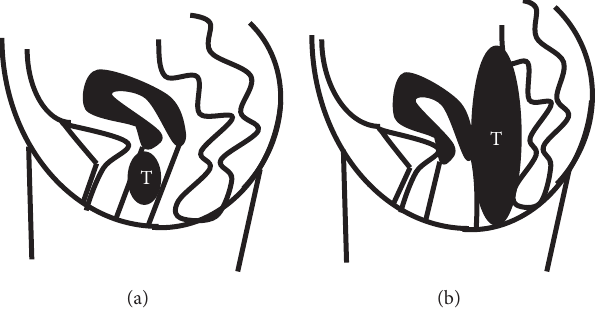
Figure 1: (a) A schematic is shown of the typical location of a smooth muscle tumor (T) of the vagina with a submucosal growth pattern or a pedunculated growth pattern from anterior vaginal wall into the vaginal cavity. (b) In the present case, a vaginal tumor (T) presented a pedunculated growth pattern from the posterior vaginal wall into pelvic cavity, occupying the pelvic cavity.